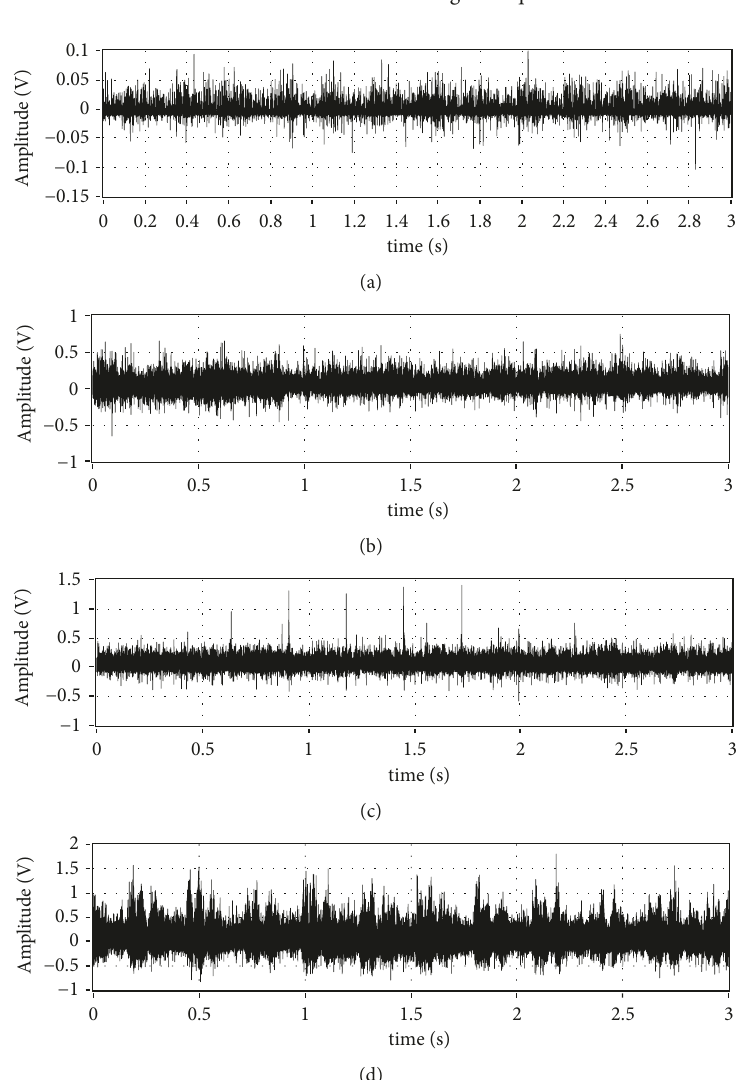
Figure 7: Time domain waveforms of vibration signal: (a) machine idling; (b) initial tool wear; (c) normal tool wear; (d) severe tool